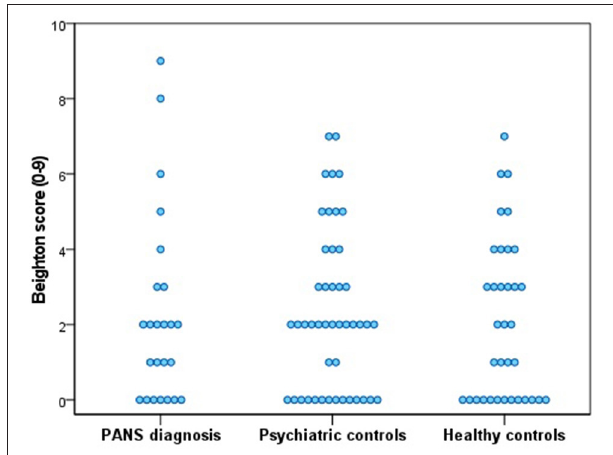
FIGURE 2 | Individual Beighton scores of all